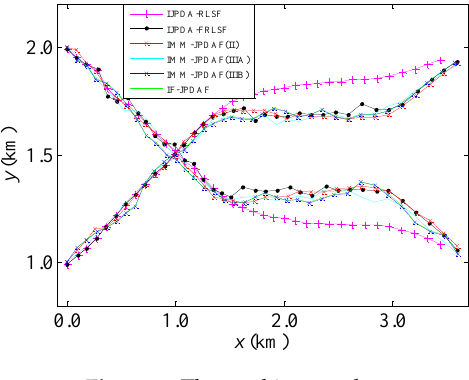
Figure 7. The tracking results. Information 2018 , 9 , x FOR PEER REVIEW